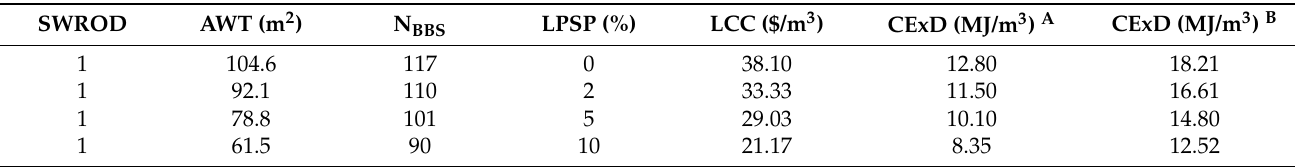
Table 1. LCC and CExD or producing 1 m 3 of freshwater according to the optimal size of system components. Data associated with the size of system components extracted from